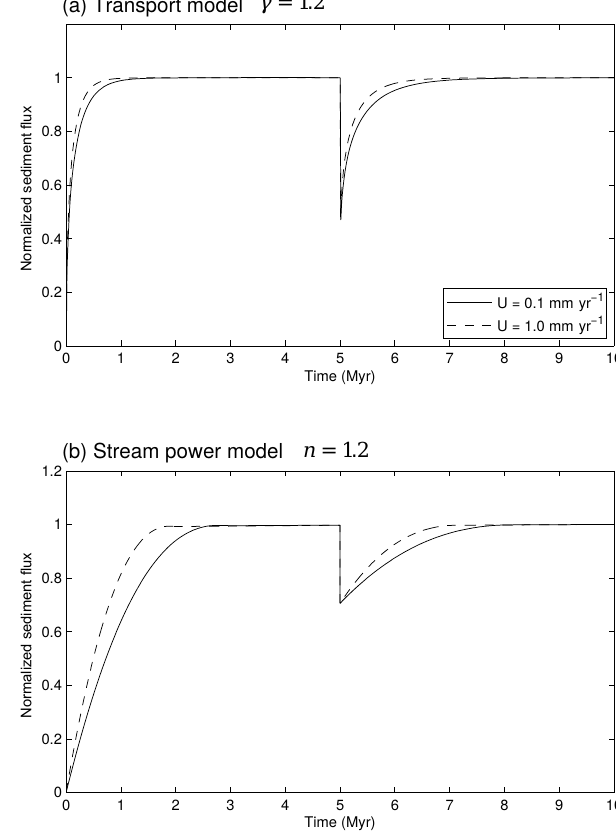
Figure 12. (a) Response of the transport model to a change in precipitation rate for two values of uplift, 0.1 and 1.0mmyr − 1 . Equation (8) is solved for γ = 1 . 2, δ = 1 . 5, p = 1 . 1, and c = 5 × 10 − 5 (m 2 yr − 1 ) 1 − δ . The precipitation rate is initially α 0 = 1myr − 1 and changes to α 1 = 0 . 5. (b) Response of the stream power model to a change in precipitation rate for two values of uplift, 0.1 and 1.0mmyr − 1 . Equation (12) is solved for n = 1 . 2, m = 0 . 5, p = 1 . 1, and k = 1 × 10 − 4 m − 1 (m 2 yr − 1 ) 1 − m . The pre- cipitation rate is initially α 0 = 1myr − 1 and changes to α 1 = 0 . 5 after